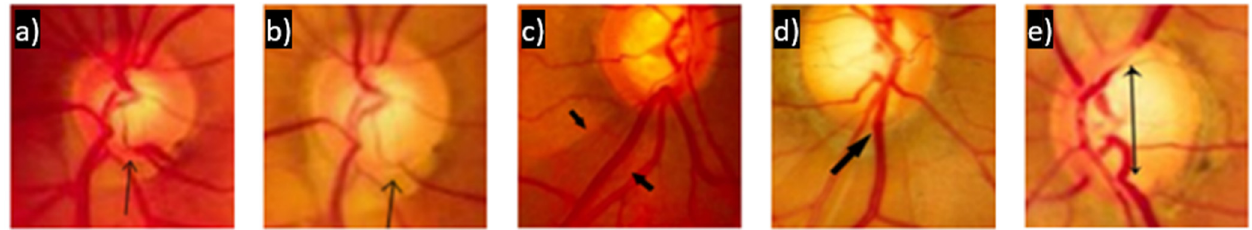
Figure 5. Example of changes in the glaucomatous papilla. ( a , b ) show the loss of nerve fibers in the inferior pole of the optic papilla; ( c ) the appearance of a wedge-shaped defect (localized RNFL defect–Hoyt sign); ( d ) shows the atrophy located in the inferior pole; ( e ) shows the increase in the vertical diameter of the papilla.